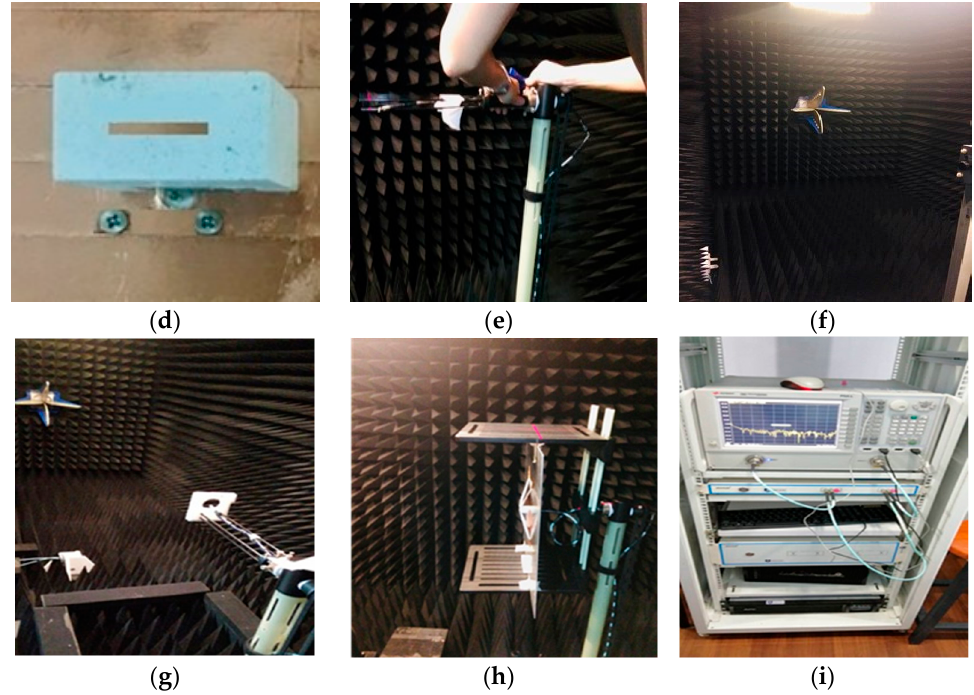
Figure 11. Fabricated Antenna and pics from the chamber. ( a ) Simple RDRA, ( b ) single strip, ( c ) cross-shape feed, ( d ) top view of proposed RDRA with floating parasitic patch, ( e – h ) AUT in the chamber, and ( i ) VNA.